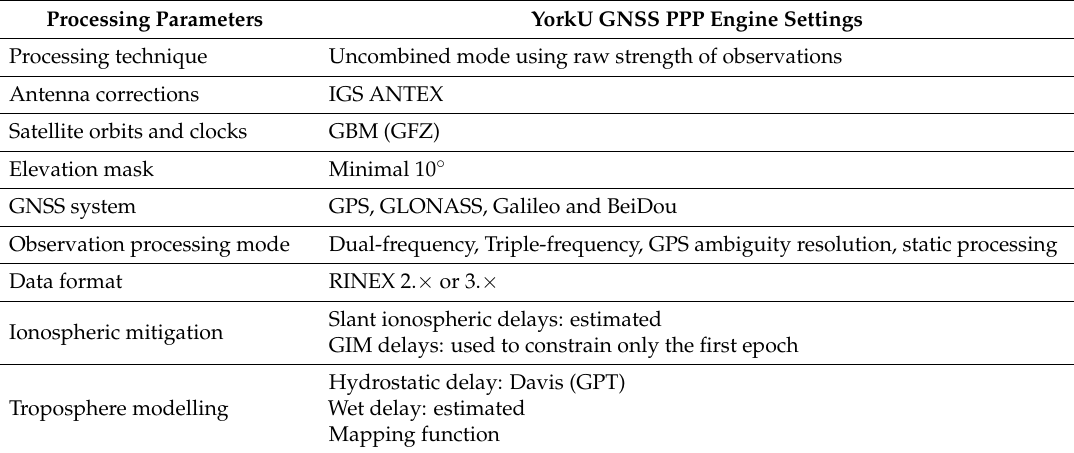
Table 1. Processing strategy and parameters used in YorkU GNSS PPP engine for data analysis.